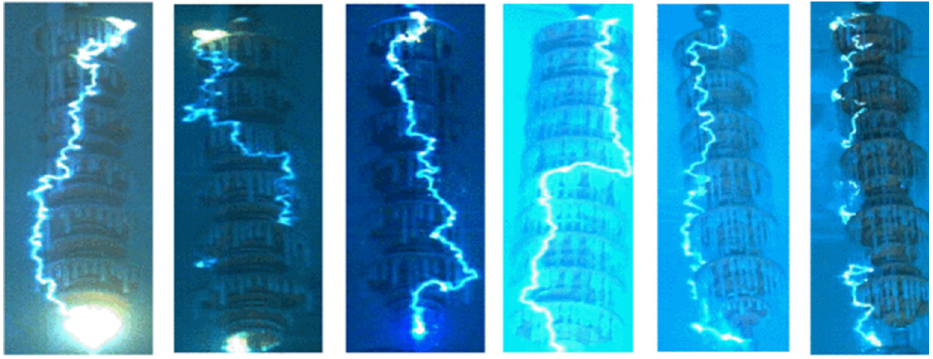
Figure 25. Discharge path of composite insulators of different types